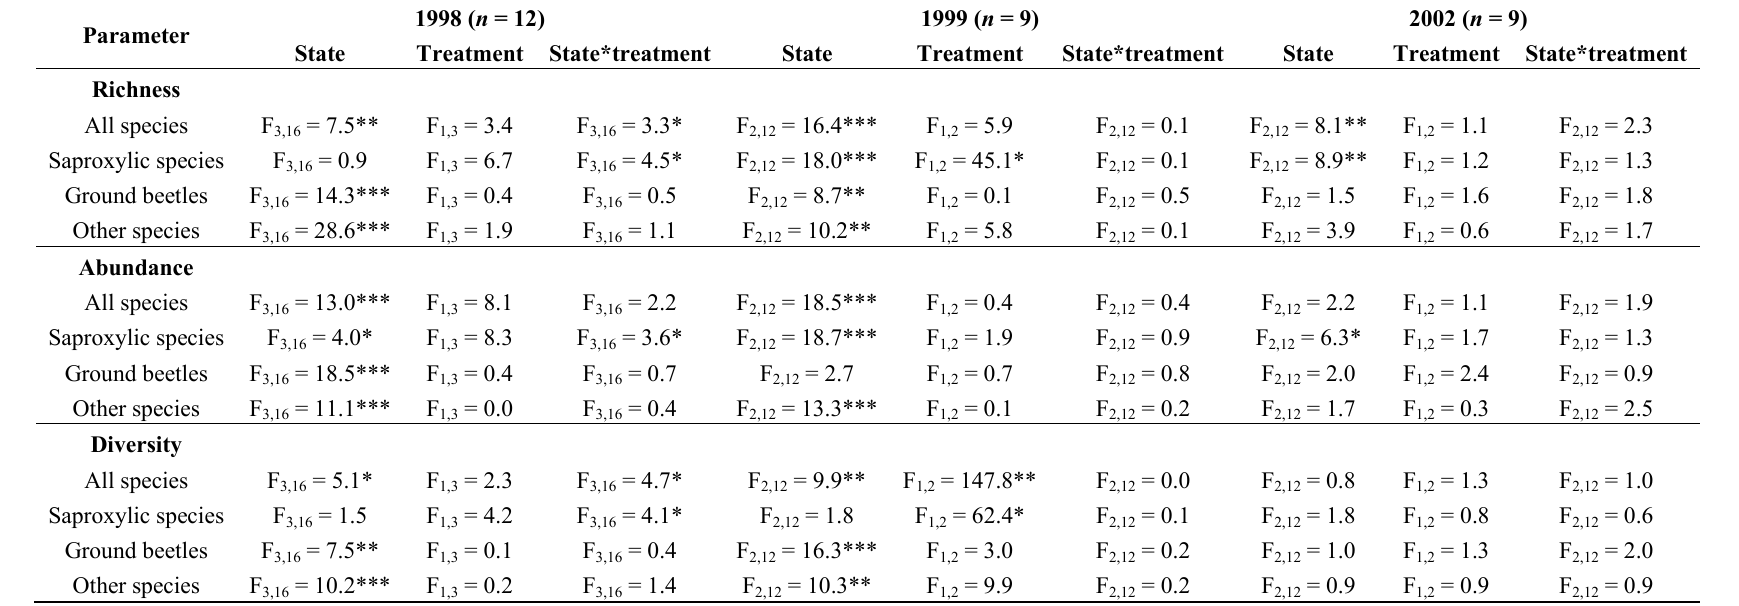
Table 1. Results from analyses of variance for all species combined, saproxylic species, non-saproxylic ground beetles and other species. Note that data from North Carolina are limited to 1998. Asterisks denote significant p -values: * < 0.05, ** < 0.01, *** < 0.001 based on analyses of